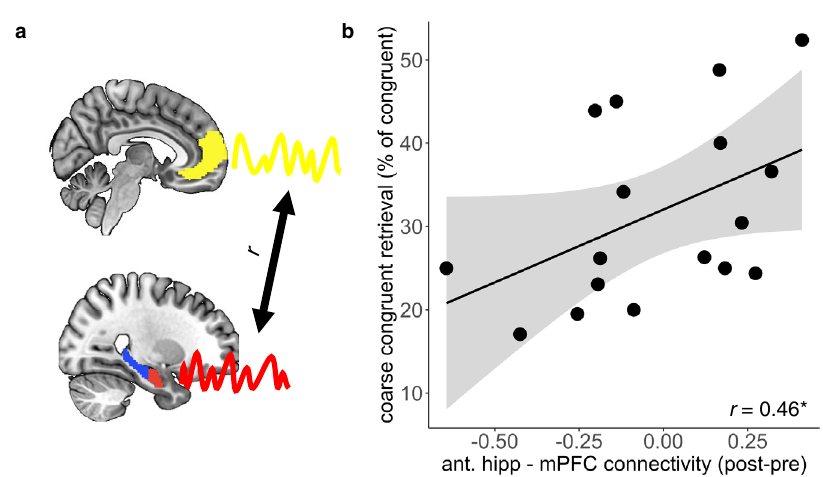
Fig. 3 | Anterior hippocampus – mPFC increase in post-encoding coupling is associated with coarse congruent memory 3 days later. a Time series from the anteriorhippocampus and mPFCwereextracted and correlatedduring baseline and post-encoding rest. Pre-encoding anterior hippocampus – mPFC con- nectivity was subtracted from post-encoding connectivity to derive a measure of post-encoding change in connectivity. b Correlation between anterior hip- pocampus and mPFC post-encoding change in coupling and coarse congruent memory 3 days later ( t (15)=1.98, p =0.033, r =0.46, CI: [0.05 – 1]). Coarse con- gruentmemorywasquanti fi edasthepercentoftotalcongruentjudgements for which the context was correctly retrieved but the speci fi c scene was not. The black dots re fl ect data from individual participants, and the black line re fl ects